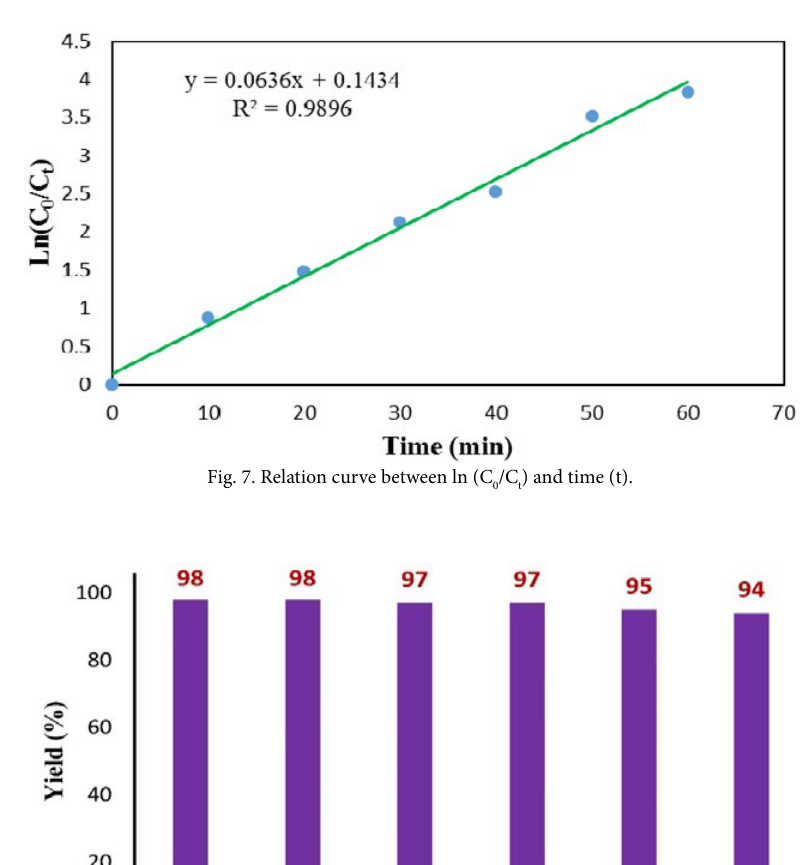
O MNPs (MgFe O = 0.015 g, MG =20 mg/L). 2 4 2 4